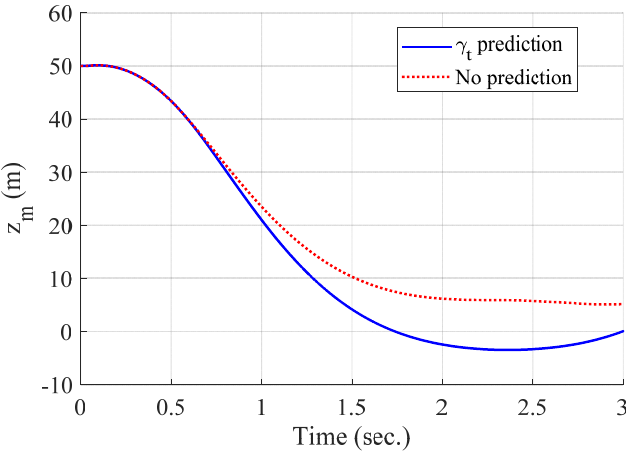
Figure 4. Relative displacement between the target and the missile (single-run simulation).